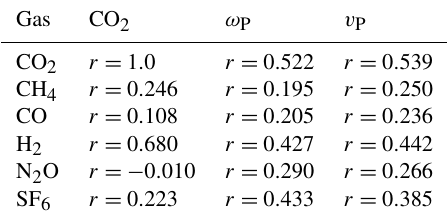
Table 3. Correlations (r) between the detrended mlo–cgo gas anomalies for CO 2 , CH 4 , CO, and H 2 with CO 2 and u duct in- dex of transient transport averaged between February and April for 1992–2016. Also shown are corresponding correlations for N 2 O and 1993–2016 and for SF 6 and 1998–2012.